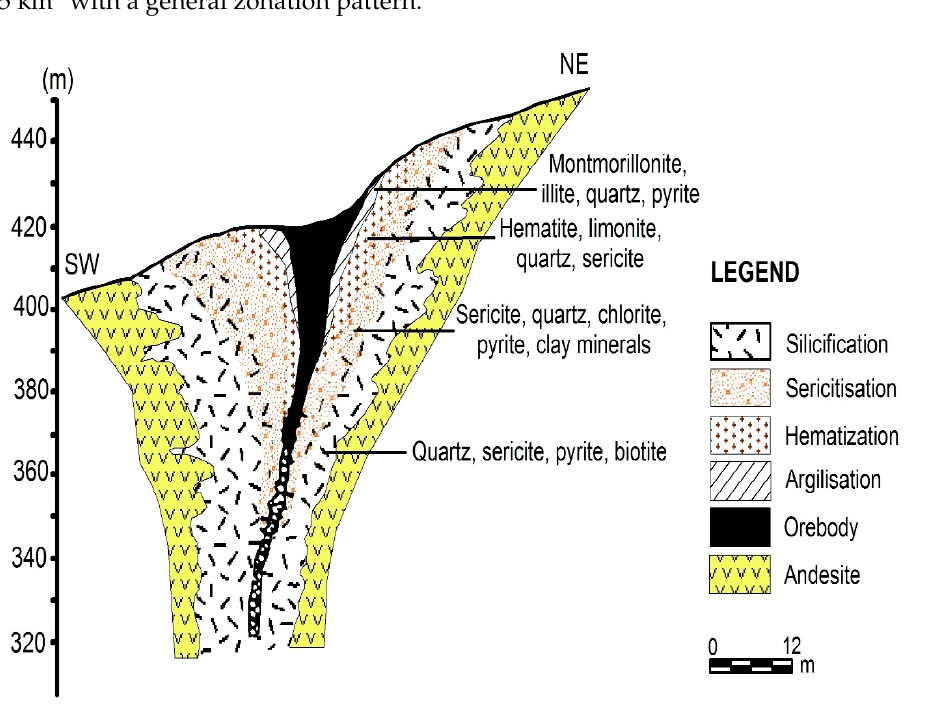
Figure 3. Hydrothermal alteration zones at the Tumanp ı nar ı deposit.